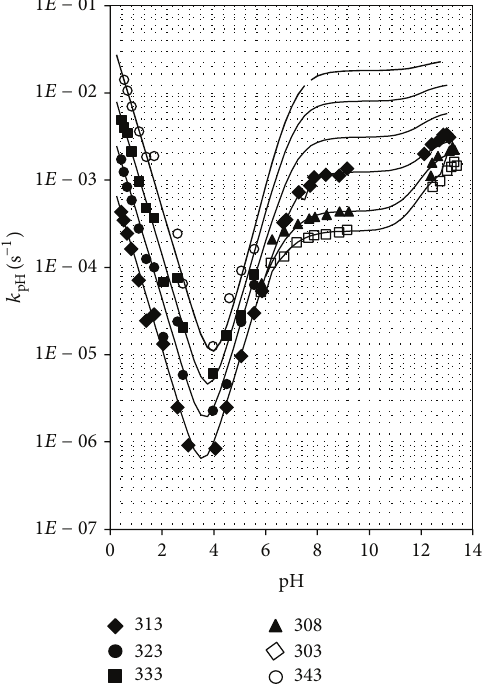
= 𝑓( pH ) profiles for the degradation of PPD in Figure 2: log 𝑘 pH aqueous solutions. The points are determined experimentally and the lines were calculated from